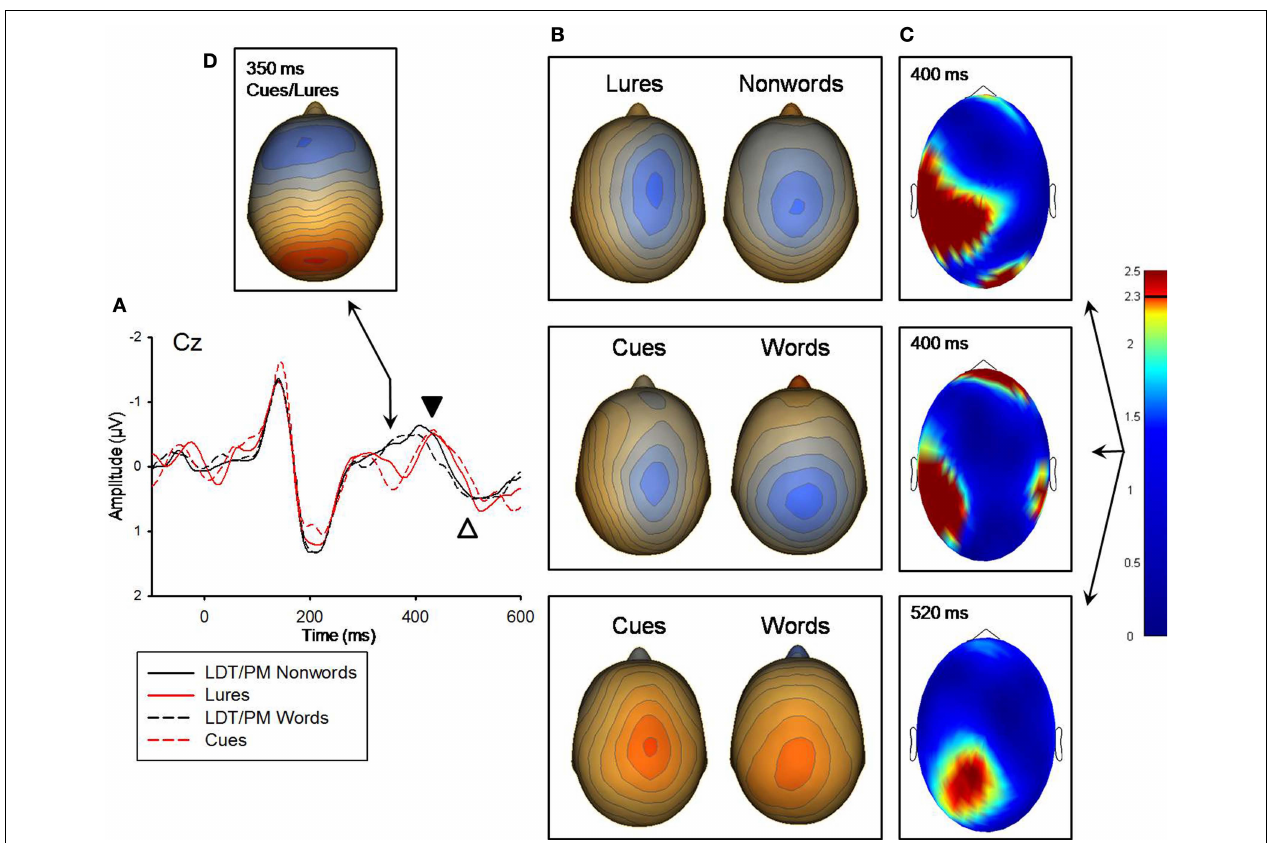
FIGURE 4 | (A) Grand-averaged ERP waveforms for LDT/PM-nonwords, lures, LDT/PM-words, and cues for the 350 ms, 400 ms (marked with black arrow), and 520 ms (white arrow) components. ERP waveforms were derived from electrode Cz which best represented each component. Negative is plotted up. (B) Topographical voltage distributions averaged within time windows centered on the peak latency of each component for which there were signifi cant effects. Positive isopotential lines are in red, negative isopotential lines are in blue. Isopotential line scales are: 0.32 µV/step for 400 ms and 0.29 µV/step for 520 ms ERPs. Due to differences in between condition t -value distributions, lures versus LDT/PM-nonwords and cues versus LDT/PM-words are